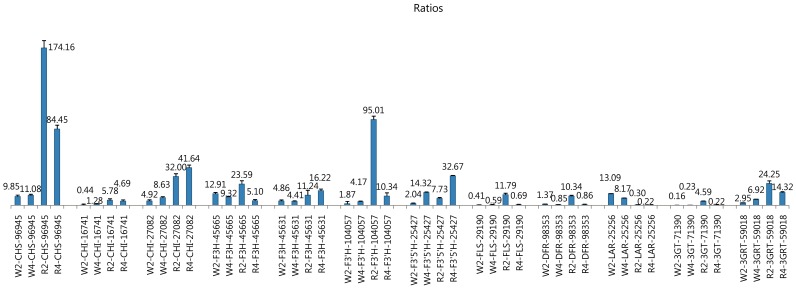
qRT-PCR analysis of 12 flavonoid biosynthetic pathway-related candidate unigenes in white and red flowers.W2, flowering day 2 of the white flower; W4, flowering day 4 of the white flower; R2, flowering day 2 of the red flower; R4, flowering day 4 of the red flower. The numbers after the gene name means the serial number of unigene. The gene sequences used for qRT-PCR analysis are shown in File S5.